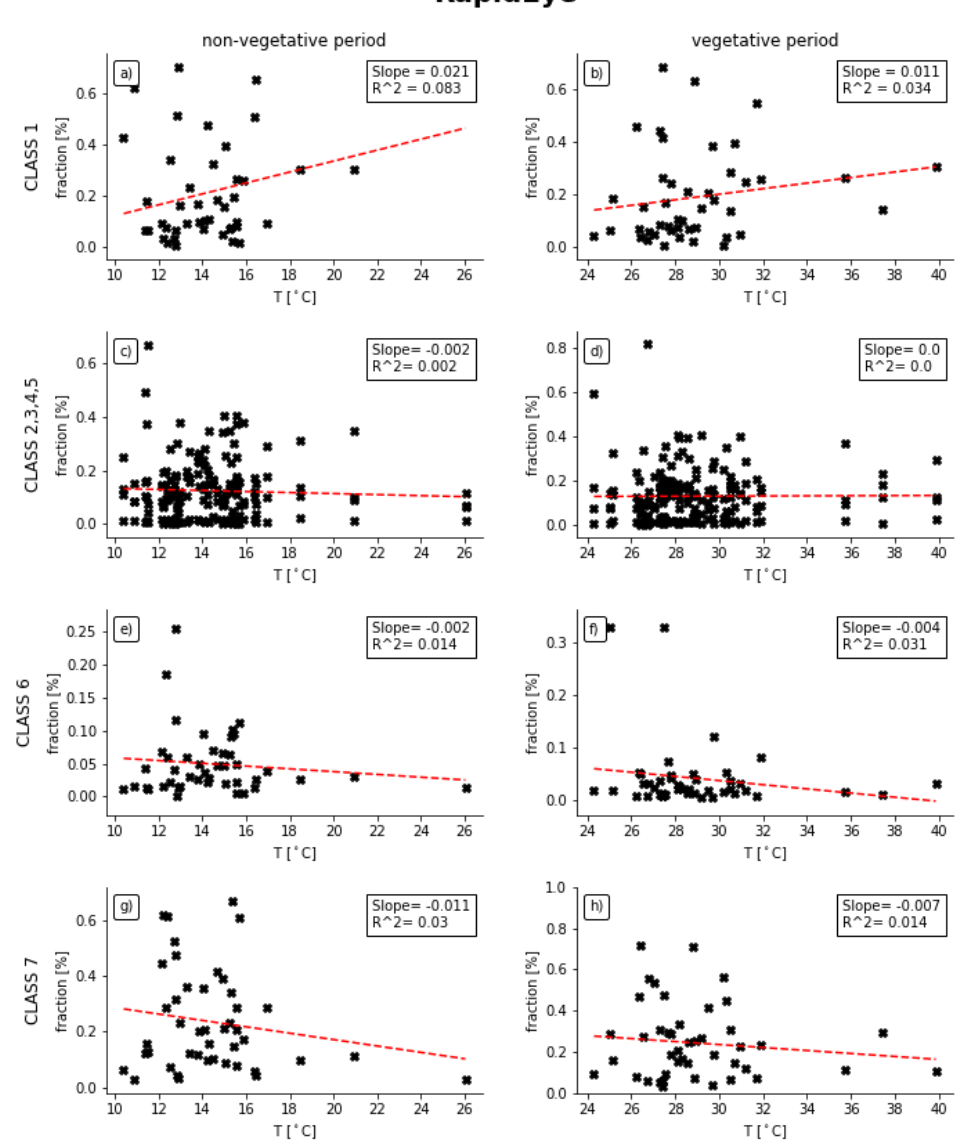
Figure 10. LCZ class fractions [%] computed into the 500 m buffer around the stations versus the measured air temperature at the stations. Air temperature measurements correspond to the hour of the RapidEye imagery acquisition. Acquisition times are 18 March 2016 at 11:14 a.m. GMT (non-vegetative period) and 22 June 2016 (vegetative period) at 10:46 a.m. GMT. Red Lines and text boxes show the results of the linear regression for each